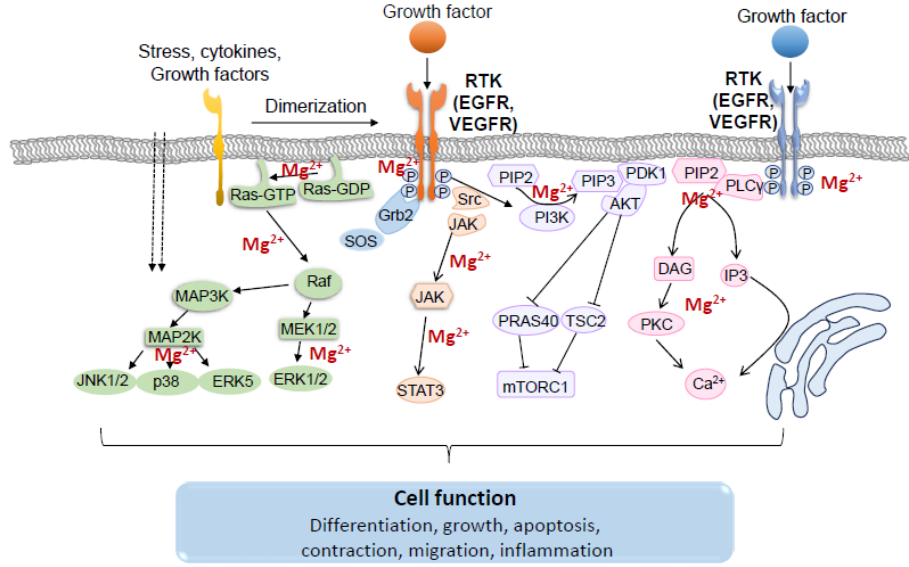
Figure 5. Schematic representation of main signaling pathways activated by growth factor signaling through receptor tyrosine kinases (RTK) and the importance of Mg 2+ . Ligand-induced dimerization triggers transphosphorylation of tyrosine residues located in the receptor chain, resulting in activation of RTKs. Intracellular signaling cascades activated by RTKs include the MAPK pathway, the PI3K/AKT/mTOR pathway, the JAK/STAT pathway, the PLCγ/PKC pathway and the Src pathway. The functional response of these signals plays an essential role in the regulation of many physiological processes. Dotted arrows indicate activation through the cell membrane; Solid arrows indicate activation of target protein; T indicates inhibition.